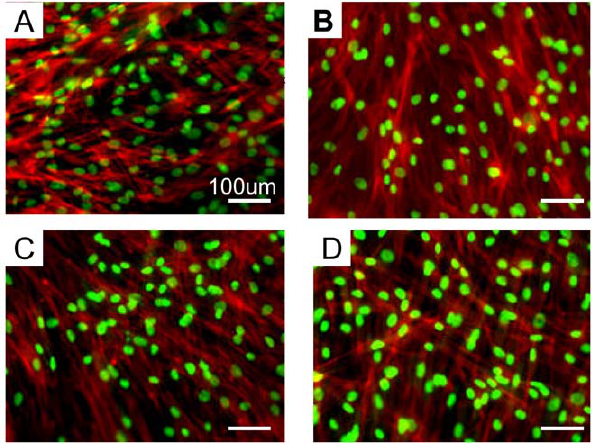
Figure 2. Cell morphology on the different scaffolds after two weeks culture. Fluorescence microscopy image of periodontal ligament fibroblasts A) on RADA16, B) on PRG, C) on PDS and D) on rat type I Collagen as a positive control. Fluorescenct staining with Rhodamin phalloidin for F-actin (red) and SYTOX Green for nuclei (green) showed the cell attachments and distributions. The scale bar represents 100um for all images. doi:10.1371/journal.pone.0010305.g002 PLoS ONE |